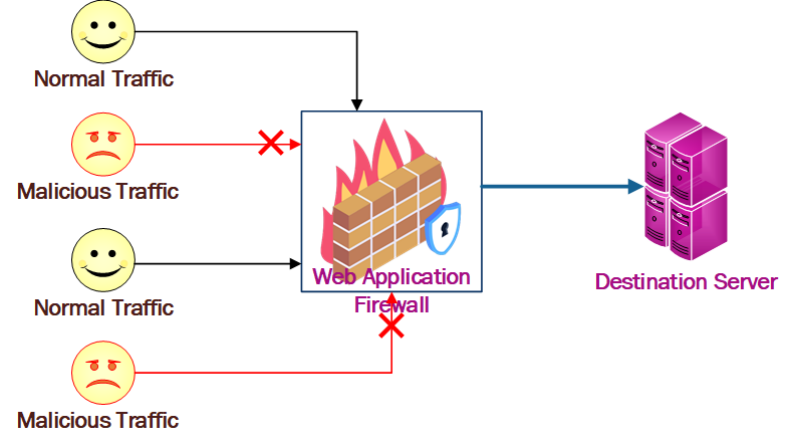
Figure 1. Working of web application